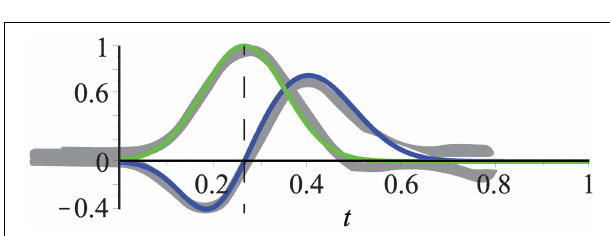
domain and illustration of spatial fitting of analytical (red) and experimental data (gray) from De Valois et al. (2000). Parameters in all plots have been set to σ 25 and f 0 0 . 08 . = =